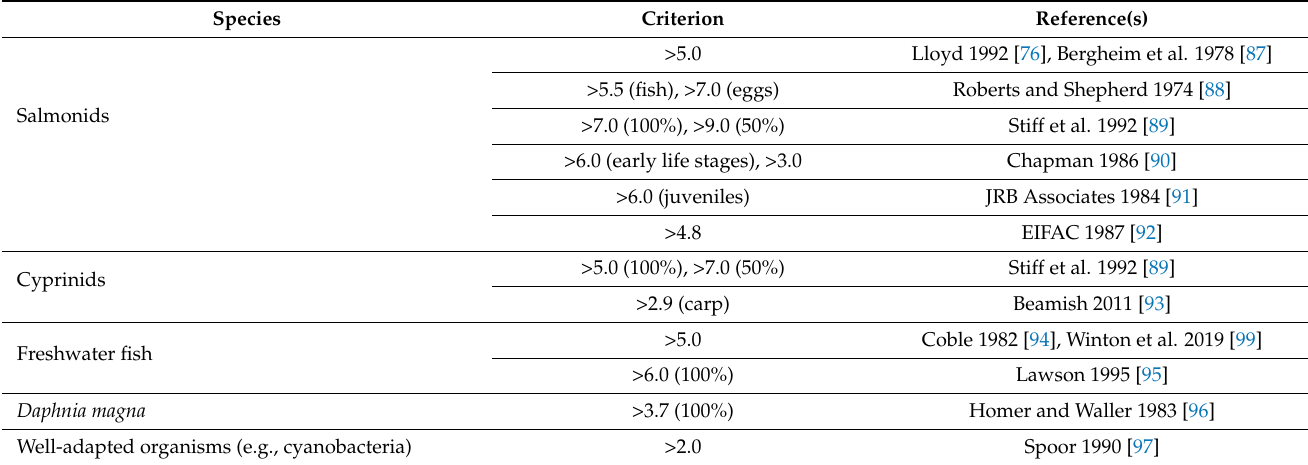
Table 11. Examples of dissolved oxygen concentrations necessary for the life of various groups of aquatic